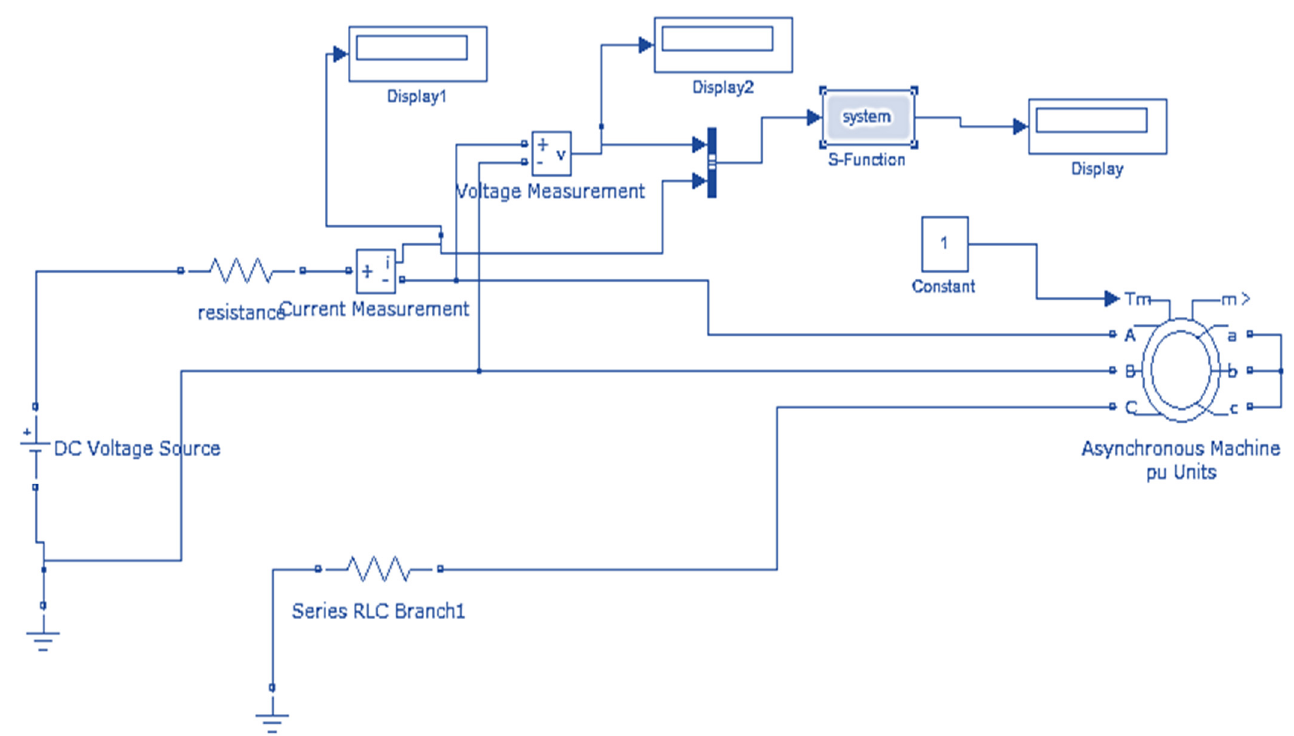
Figure 12. DC resistances test.